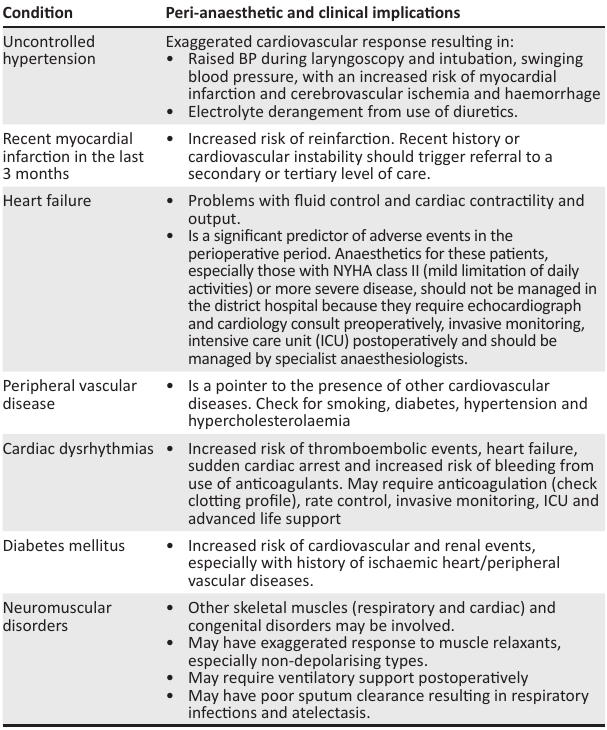
TABLE 1 : Common medical conditions and associated risks in the perioperative